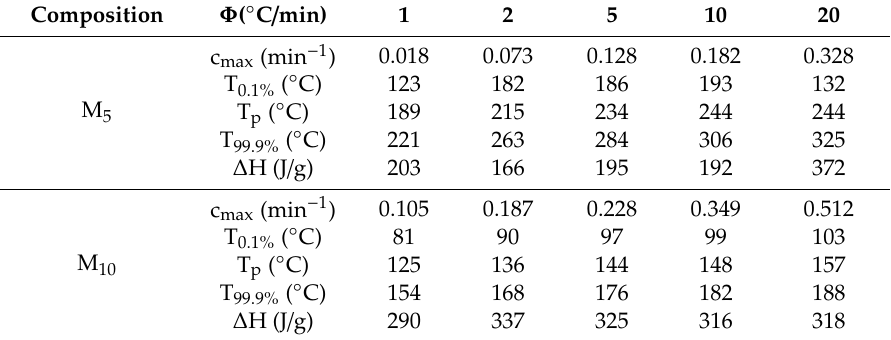
Table 5. Cure parameters M X 100:87:X.